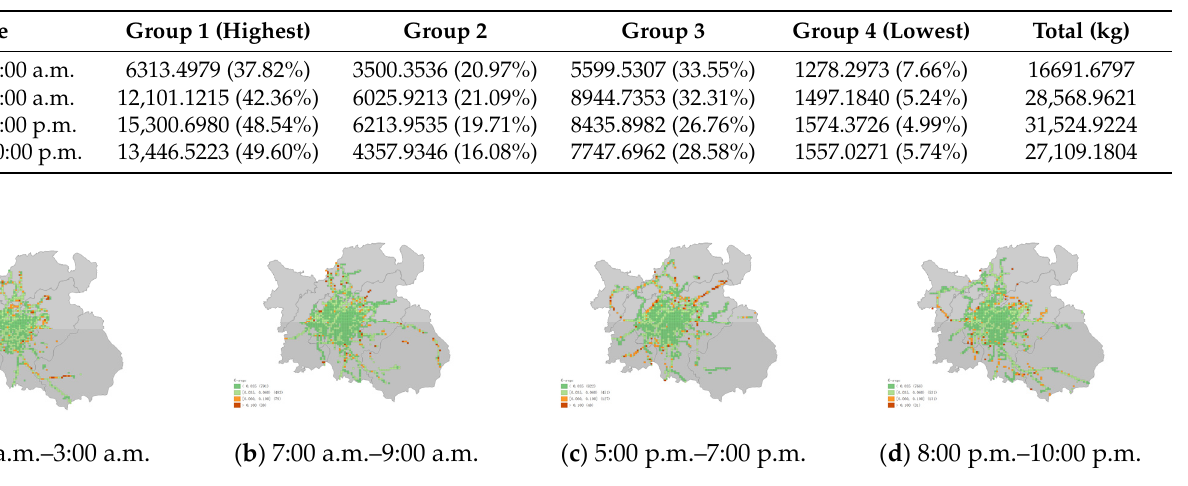
Table 4. Share of emissions and total emissions for each group of grids.